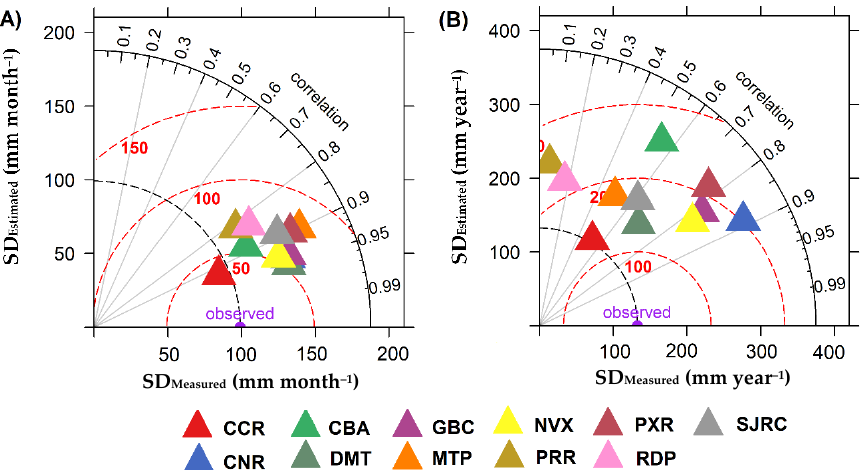
Figure 10. Taylor diagrams showing the comparisons of ( A ) monthly (mm month − 1 ) and ( B ) annual (mm year − 1 ) of the GPCP product at each of the weather stations in the state of Mato Grosso, Brazil. In panels ( A , B ), the Pearson correlation coefficient (r) was represented by the azimuth angle (black outlines), the RMSE was represented by the red dashed outlines, and the standard deviation (SD) was indicated by the axes x and y, respectively. For ( A ), the monthly values for the entire study period were averaged, while for ( B ), the annual values for all years during the study period were averaged.